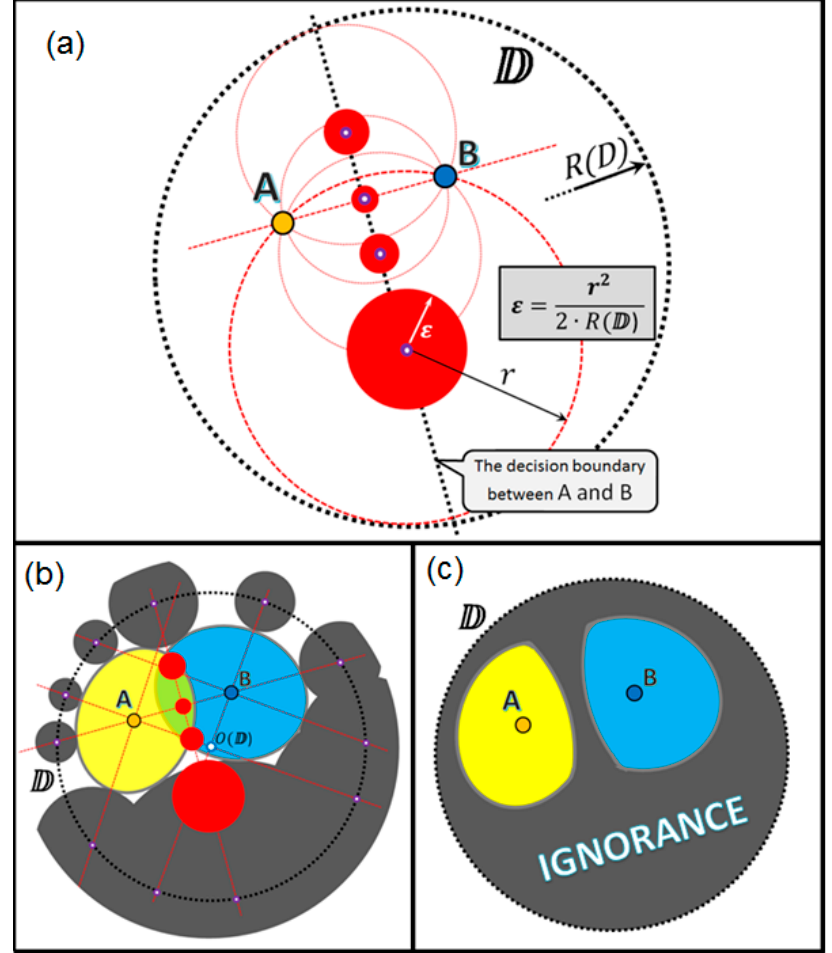
Figure 10. Illustration of the origin and parameters of the believed certainty and the ignorance areas created by a couple of conflicting data points A and B within the domain: ( a ) the conflict between A and B makes a decision boundary between them, where all the additional ignorance zones are centered; ( b ) the discovery of the A - B -conflict-related ignorance zones may go synchronously with the A -Domain-conflict-related and B -Domain-conflict-related ignorance zones discovery; ( c ) both types of ignorance zones are merged so that the clear boundary is seen between the ignorance and two heterogeneous certainty areas.